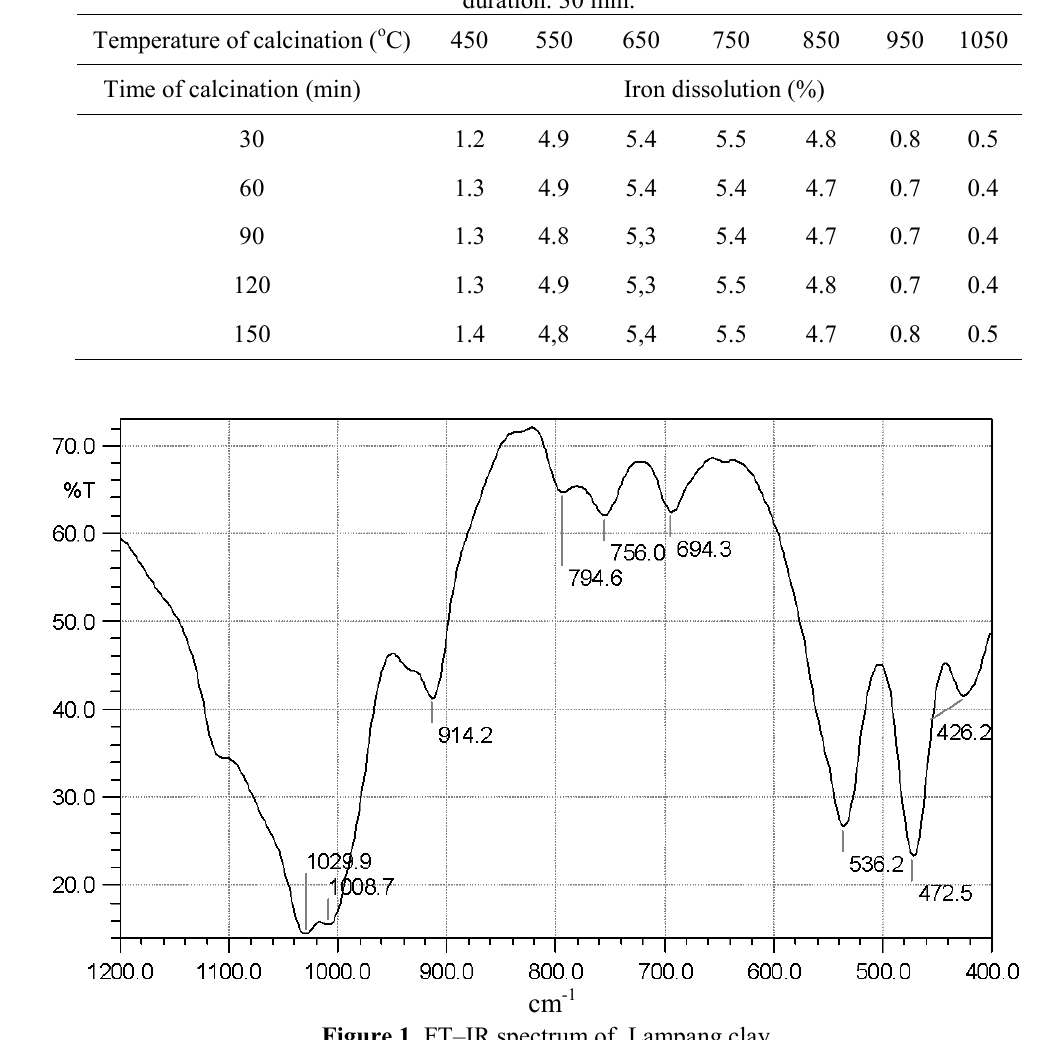
Figure 1 . FT–IR spectrum of Lampang